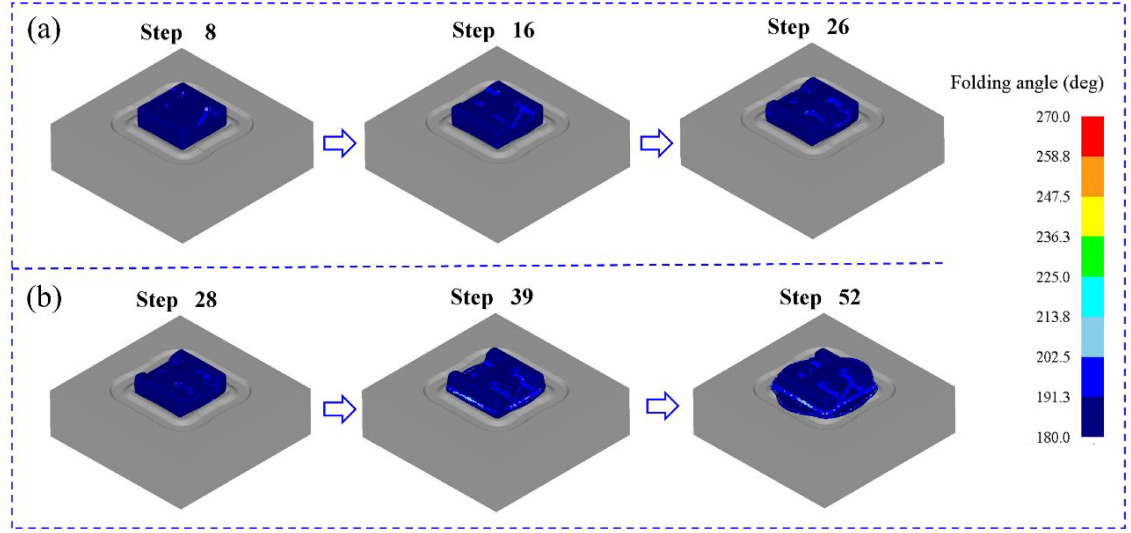
Figure 8. Distribution of folding angles during forming: ( a ) pre-forging and ( b ) final